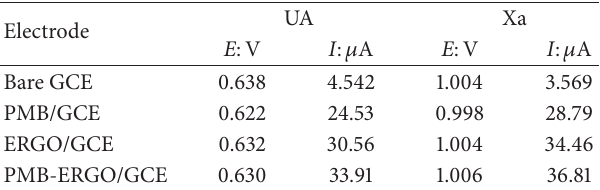
Table 1: Detail data of cyclic voltammograms at different